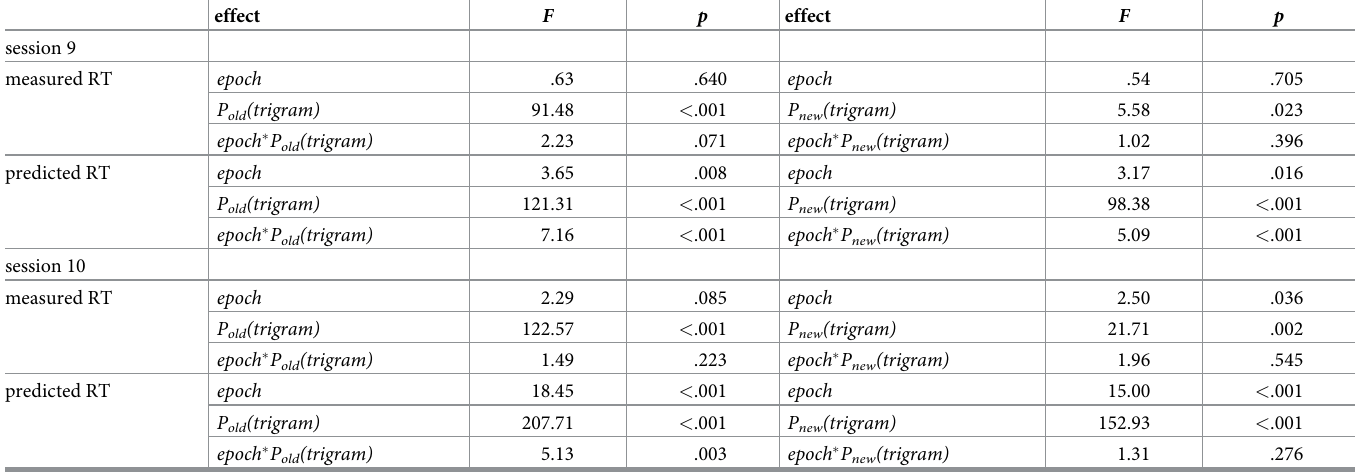
Table 3. Repeated measures ANOVAs in session 9 and 10. In the left set of columns, the trial type is defined as P old (trigram) and in the right set of columns it is defined as P new (trigram)